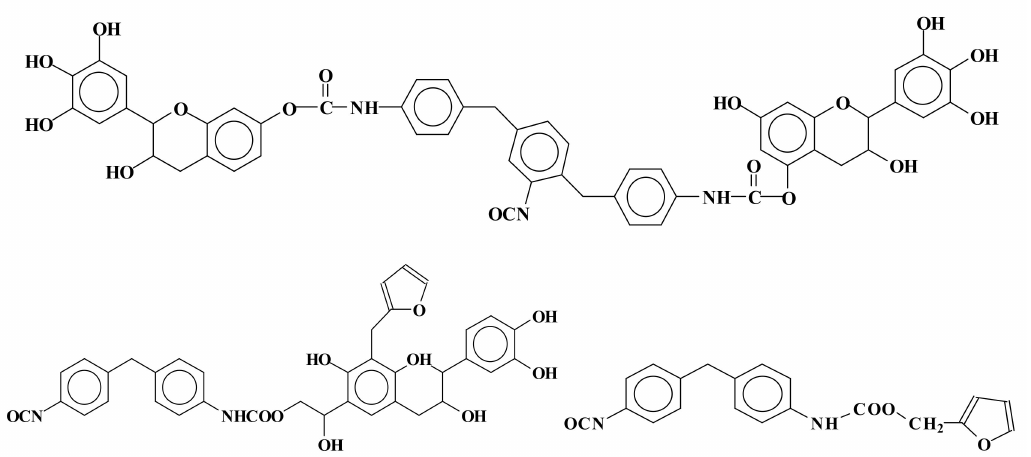
Figure 5. Examples of mixed species obtained by the reaction of tannin–furfuryl alcohol–glyoxal mixes with polymeric diphenyl methane isocyanate